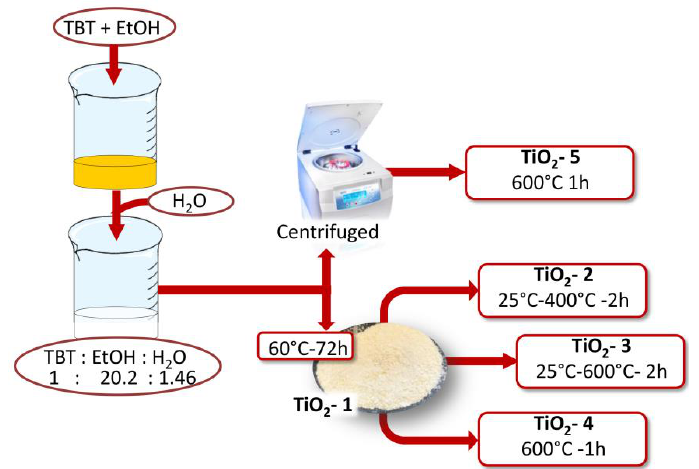
Figure 1. Flow chart of TiO 2 nanoparticles by the sol-gel method and the molar ratios between the reagents achieved in the sol.